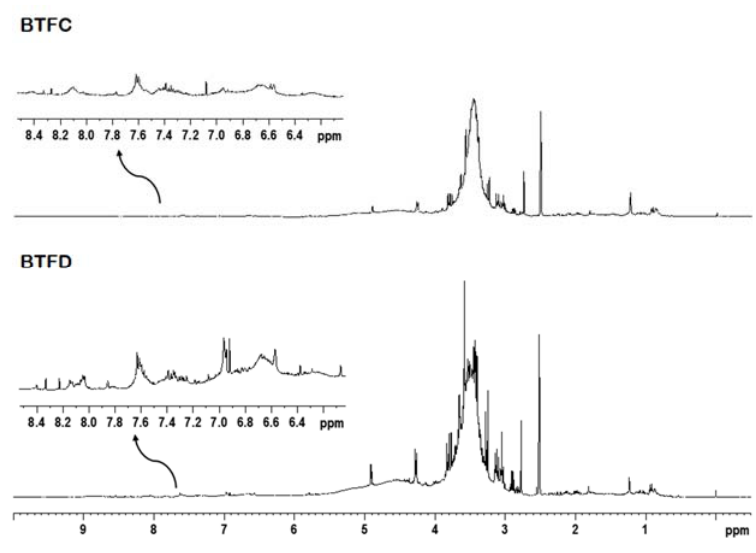
Figure 6. Representative 1 H NMR spectrum of the active fractions (BTFC and BTFD) obtained from the methanolic extract of Buchenavia tetraphylla leaves.